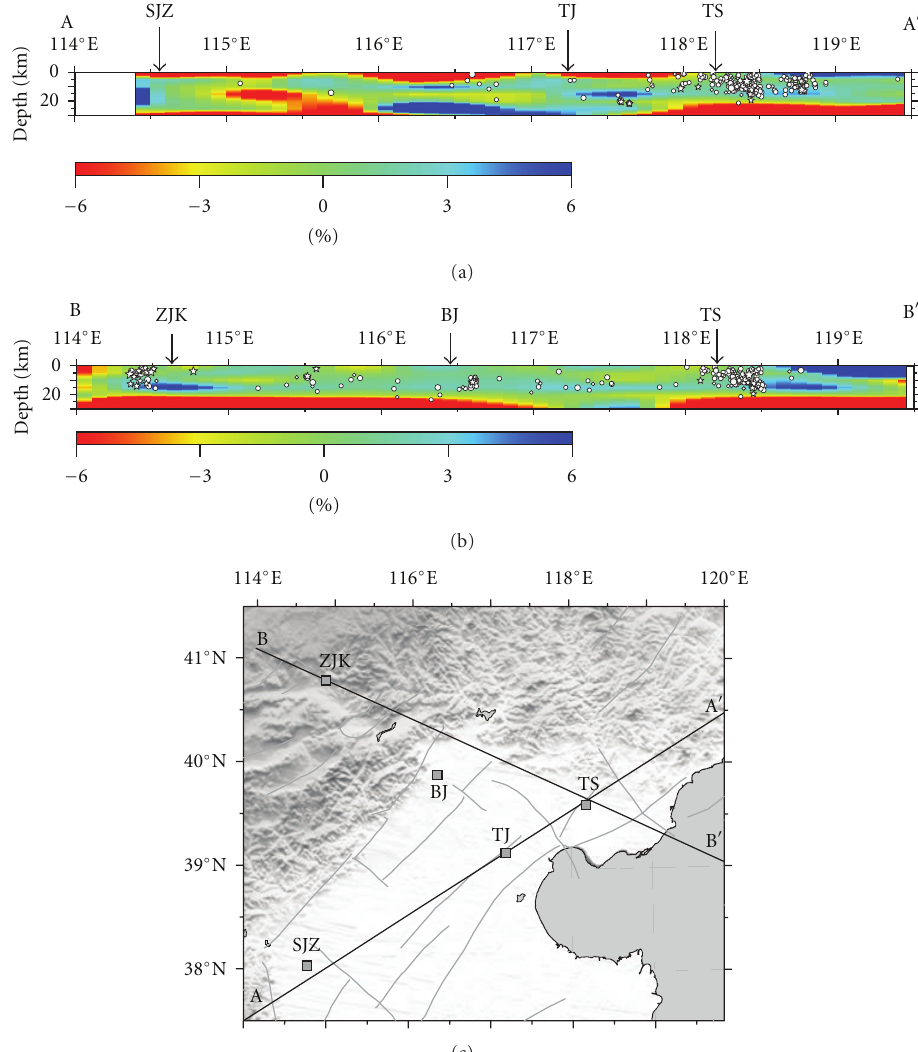
Figure 10: (a) and (b) show the vertical cross-sections of P wave tomographic image along the profiles. White stars and circles denote the earthquakes of M L ≥ 4.0 and M L < 4.0, respectively, which occurred within 0.25 ◦ o ff the profile. Red and blue colors denote slow- and fast-velocity anomalies, respectively. No vertical exaggeration. (c) shows the location of profiles. BJ: Beijing; TJ: Tianjin; TS: Tangshan; ZJK: Zhangjiakou; SJZ: